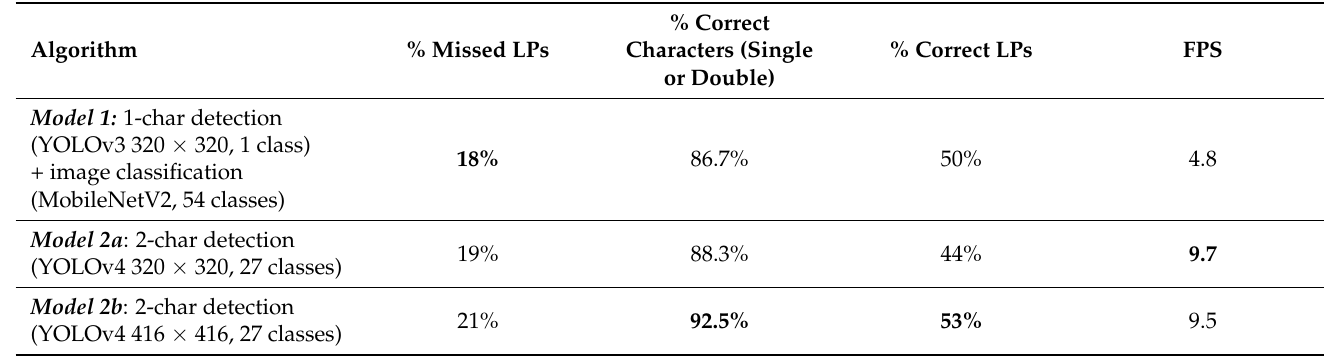
Table 9. Comparison of different algorithms tested for license plate character recognition, in terms of the percentage of missed (non-detected) license plates, correctly classified characters (over detected license plates), correctly recognized license plates (all characters recognized in correct order), and processing speed in frames per second (FPS). The results were evaluated on 100 images showing cars at various distances and view angles on a Jetson Xavier